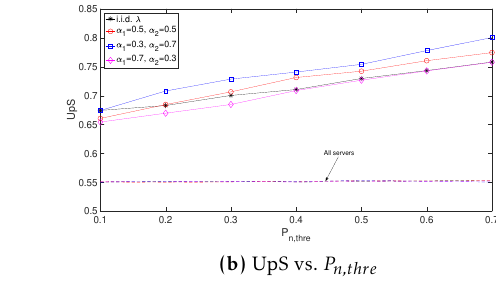
Figure 4. Impacts of user arrival probabilities